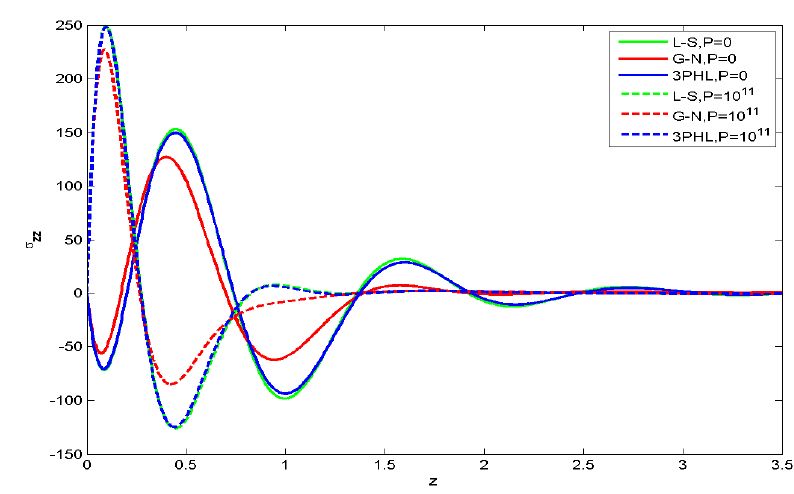
Figure 5. Normal stress σ zz concerning z under thermoelastic theories.